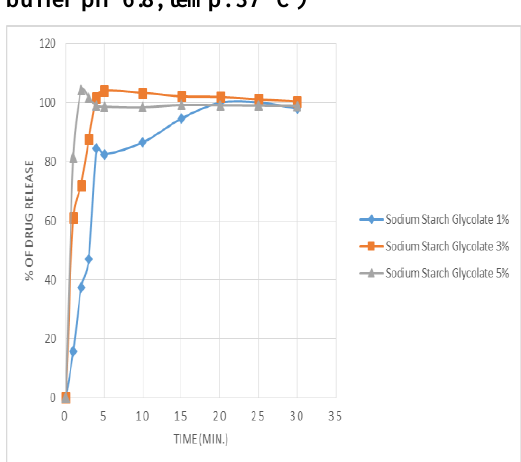
Figure 1. Effect of superdisintegrant type on drug release from core tablet (phosphate buffer pH 6.8, temp. 37 0 C)